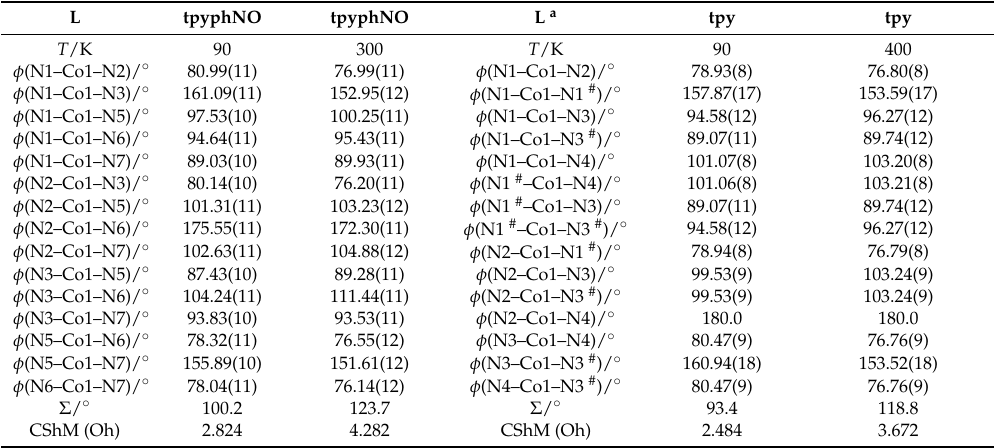
Table 3. N–Co–N bond angles ( φ in ◦ ) and distortion geometrical parameters Σ (in ◦ ) and CShM